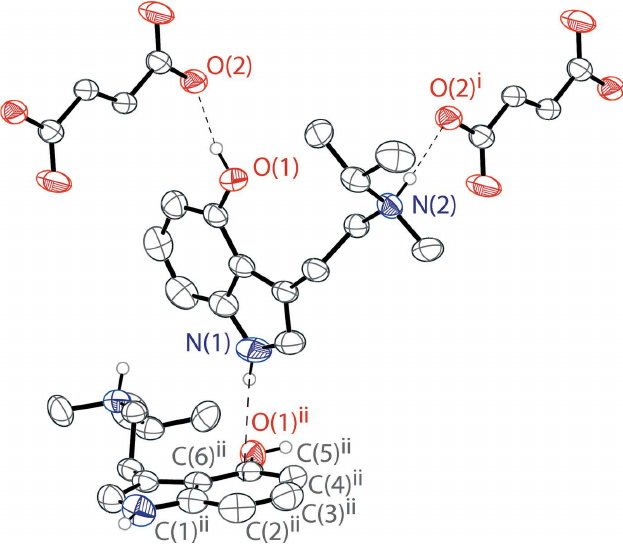
Figure 2 The hydrogen bonding of the tryptammonium cation in the structure of the title compound (Table 1), with hydrogen bonds shown as dashed lines. There is also an N—H (cid:2)(cid:2)(cid:2) (cid:2) interaction shown. Displacement ellipsoids are drawn at the 50% probability level. Hydrogen atoms not involved in hydrogen bonds are omitted for clarity. Symmetry codes: (i) 1 (cid:3) x , (cid:3) 1 (cid:3) z 1 (cid:3) z , (ii) 1 + y , 3 2 2 2